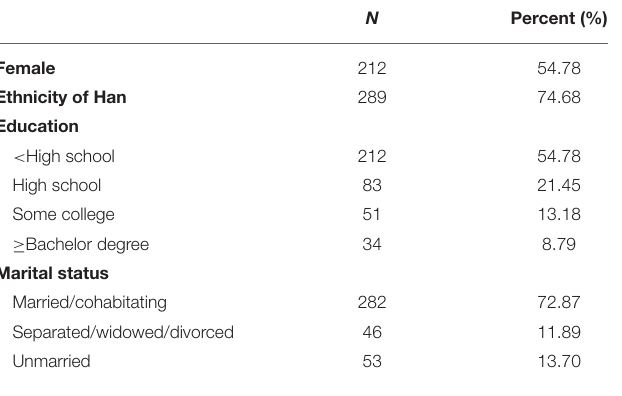
TABLE 1 | Socio-demographic of the study subjects ( N = 387).